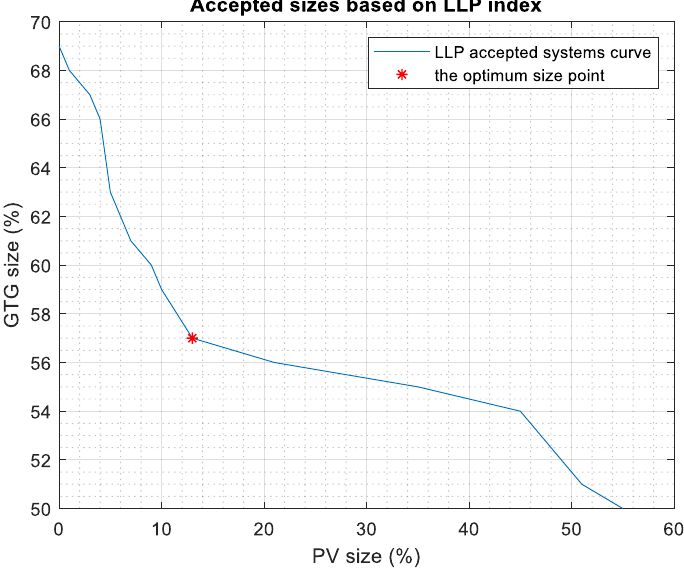
Figure 7. Loss of load probability (LLP) values in di ff erent system sizes. Figure 7 . Loss of load probability (LLP) values in different system sizes . Table 1. Cost saving